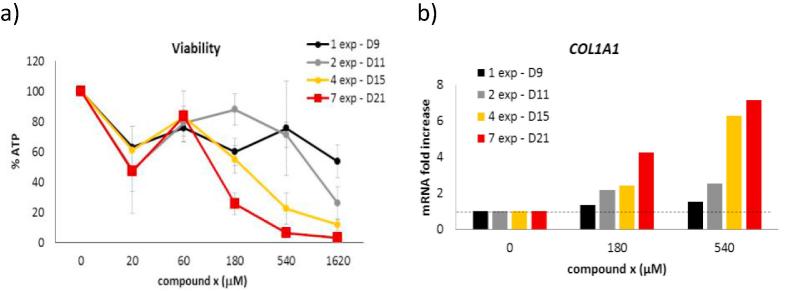
Fibrosis evidenced in hepatic organoids (3d HepaRG/HSC). a) Viability determination of organoids after 24 h exposure of chemical x after 1, 2, 4 and 7 exposures. b) D) mRNA levels of HSC activation marker COL1A1 in hepatic organoids after 1,2,4 and 7 exposures of 180 and 540 μM PBO.